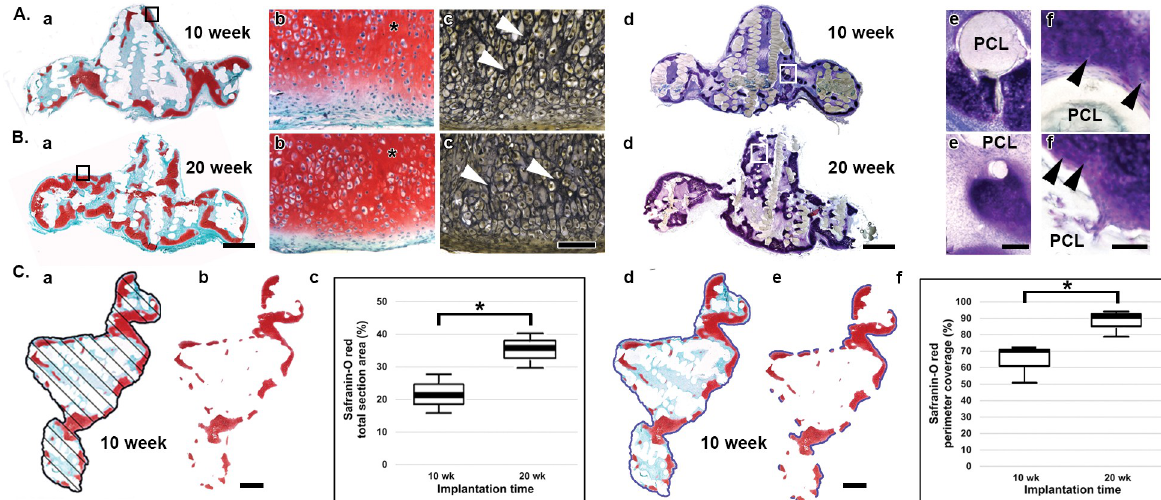
Fig 5. Representative histology and histomorphometry of human auricular cartilage regenerated on nanoPGA/PCL composite constructs consisting of ethanol-treated scaffolds and implanted for 10 and 20 weeks in nude mice. A, B and C show representative complete cross sections of constructs that were fixed, processed in paraffin and stained with Saf-O for the presence of cartilage proteoglycans. Other such sections were Verhoeff-stained for the presence of elastic fibers. Thick sections of constructs implanted for 10- (Aa) or 20- (Ba) weeks showed Saf-O staining along the periphery of the specimens with more staining evident after the longer implantation times. Enlargement of typical construct areas (Aa or Ba, black-outlined boxes) demonstrated abundant proteoglycans (asterisks) and numerous chondrocytes in lacuna (Ab and Bb) as well as elastic fibers in other corresponding construct sections (Ac and Bc, white arrows). Completely unfixed, frozen constructs that were sectioned and stained with toluidine blue revealed prominent metachromasia, indicative of cartilage, in interior regions of specimens (Ad and Bd). Cartilage was more apparent in constructs implanted for 20 weeks (Bd) than 10 weeks (Ad) and the histology correlated well with that of sections stained with Saf-O (Aa and Ba). On enlargement of certain areas (Ad or Bd, white-outlined boxes), intact PCL cores were bounded by metachromatic cartilage (Ae and Be) and presumptive chondrocytes (Af and Bf, black arrows) without evidence of inflammatory elements. Based on Saf-O presence, histomorphometric measurements were made and plotted to show percent total section area (Ca-c) and percent perimeter coverage (Cd-f). A representative Saf-O-stained section for a construct implanted for 10 weeks details two imaging steps in a calculation for Saf-O total area (Ca-b) and Saf-O perimeter coverage percent (Cd-e). A set of evenly spaced straight lines was used in total pixel area measures (Ca) and then non-staining pixel areas were subtracted to leave only Saf-O-stained pixel domains (Cb). In a related manner, a line (Cd, blue) circumscribing a scaffold was used to measure total scaffold circumference in pixels. Saf-O-stained aspects only along the same line were identified (Ce) and their total length in pixels was compared to the total circumference. These measures provide assessment of cartilage regenerated during construct implantation. Resulting box plots show significant increases ( � , p = 0.044 and p = 0.034, respectively) from 10 to 20 weeks of implantation of Saf-O total area percent (Cc) and perimeter coverage percent (Cf). Scale bars = 2 mm (Ba [Aa at the same enlargement]), 100 μ m (Bc [Ab-c, Bb]), 2 mm (Bd [Ad]), 100 μ m (Be [Ae]), 100 μ m (Bf [Af]), 2 mm (Cb [Ca]) and 2 mm (Ce